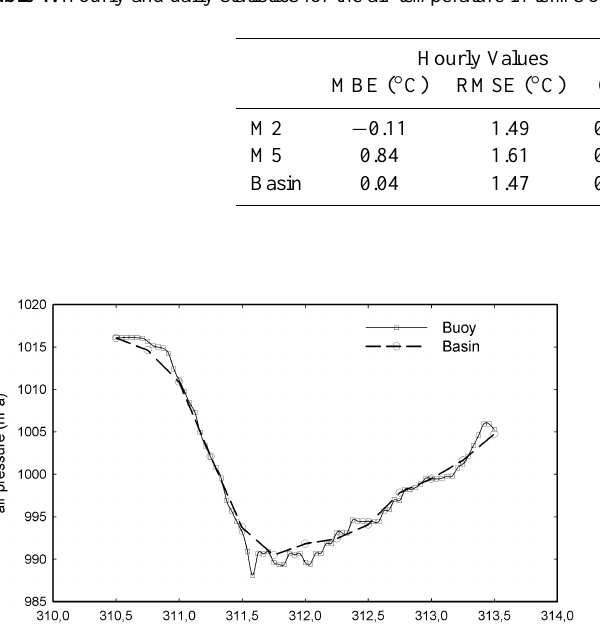
Fig. 4. Scatter plots of model vs. buoy’s air pressure hourly data for the M2, M5 grid points and the “average basin”. Table 4. Hourly and daily statistics for the air temperature in terms of mean bias error (MBE) and root mean square error (RMSE).